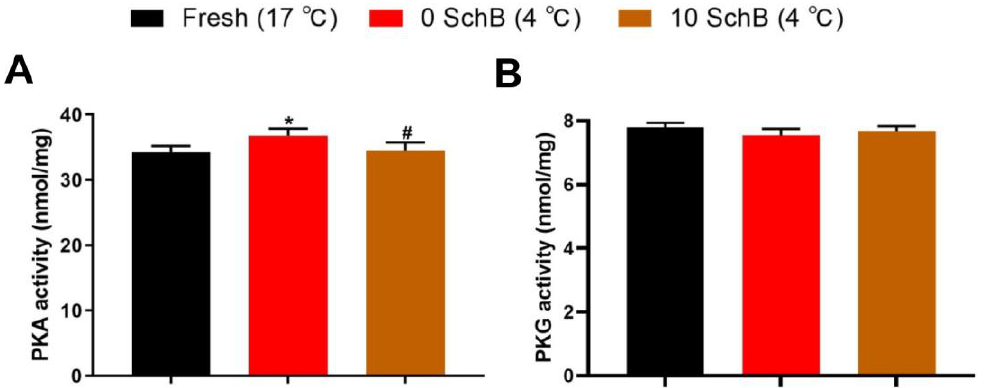
Figure 8. Effects of Sch B on PKA ( A ) and PKG Levels ( B ) in boar sperm: Data are expressed as mean ± SD ( n = 12). # p < 0.05 vs. 0 Sch B, * p < 0.05 vs. fresh.